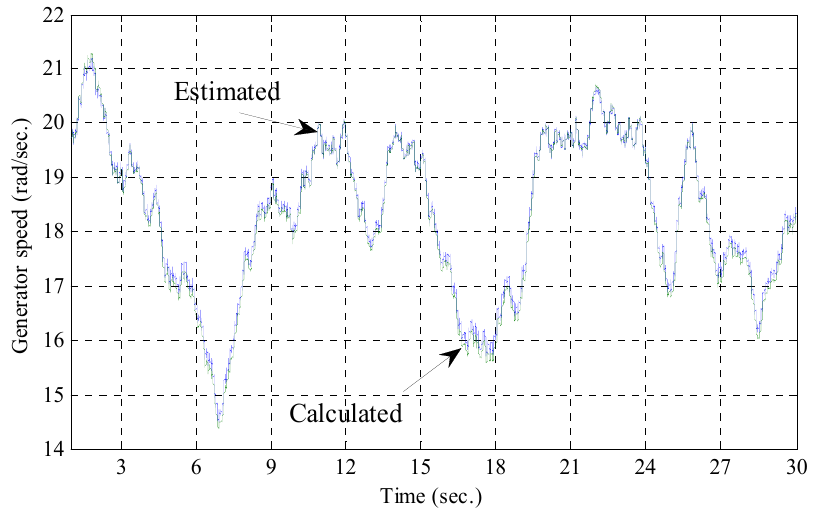
Figure 13. Percentage error of generator speed (%).